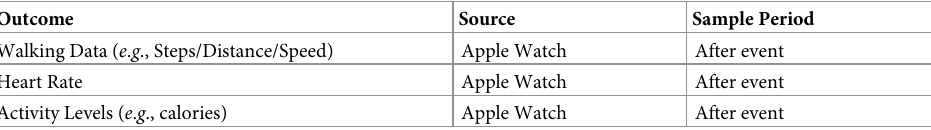
After event After event After